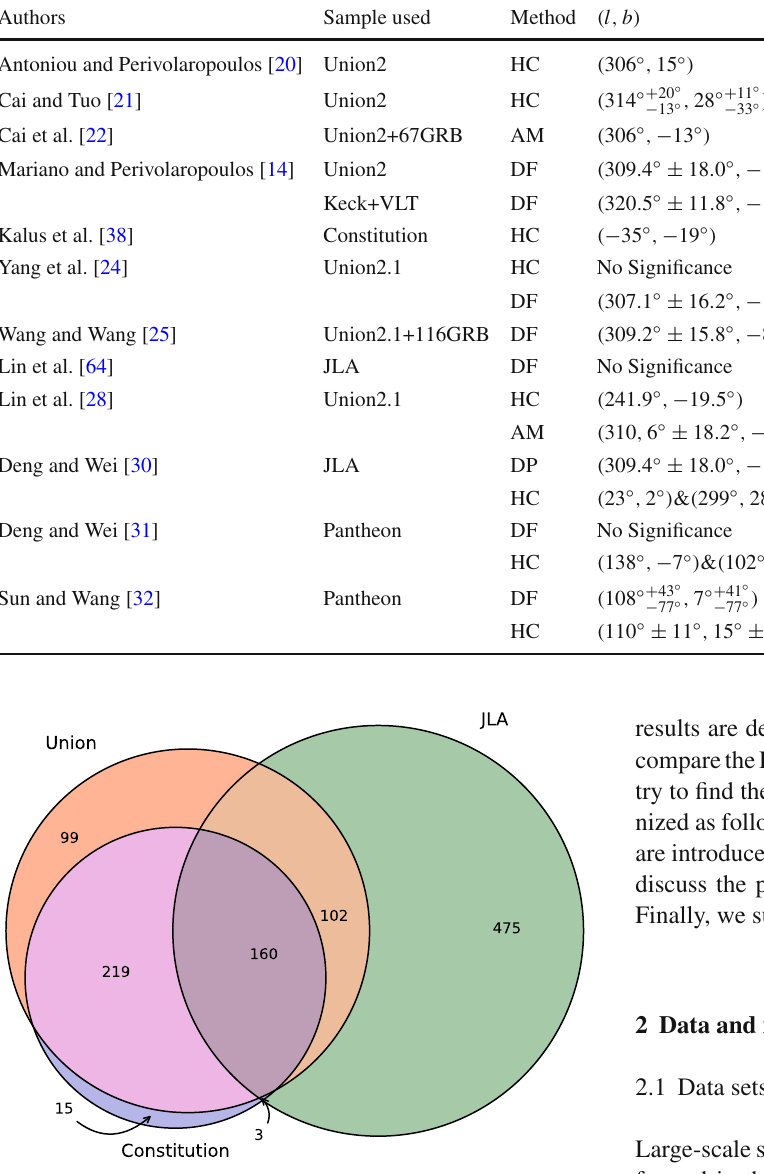
Table 2 Best-fitting results of dipole and monopole for three data sets. The confidence level (CL) is defined as the probability of the case where the dipole magnitude of an arbitrary data set in “isotropic” samples being smaller than the best-fitting dipole